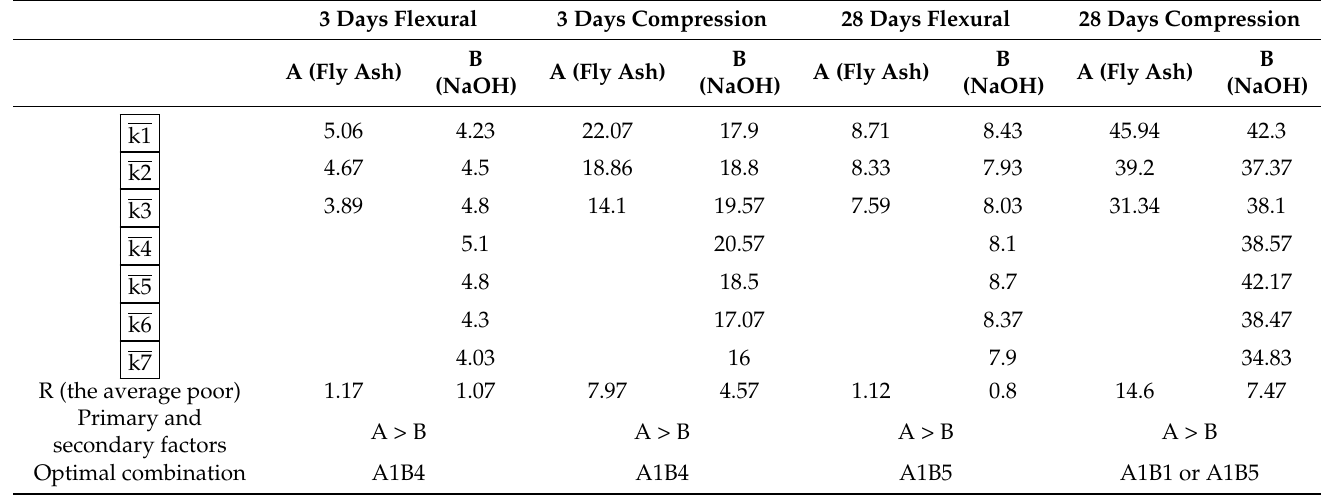
Table 2. Orthogonal test design